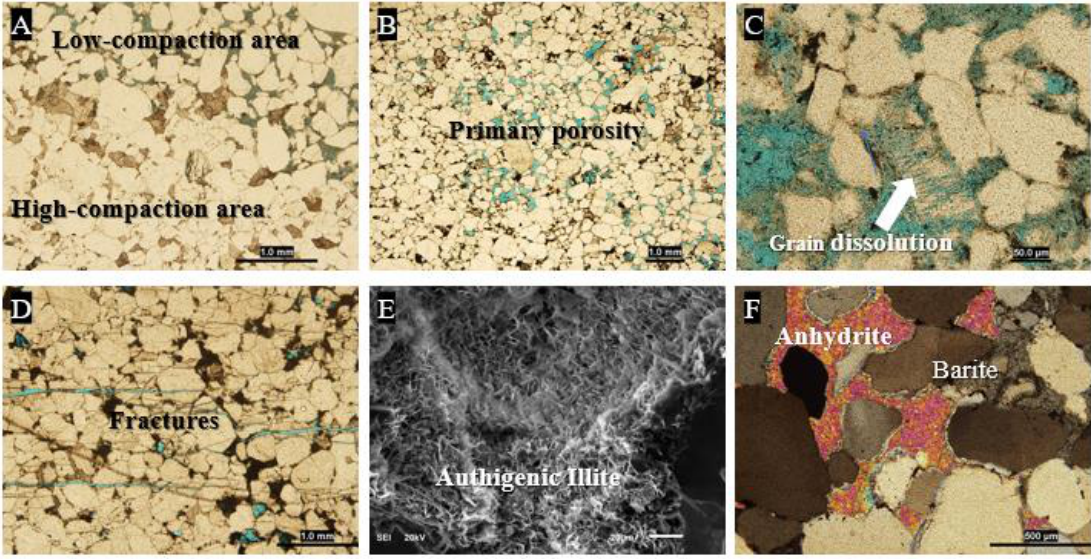
Figure 6. Photomicrographs for microfacies observed in the analyzed samples. ( A ) Heterogenous patterns of grain compactions, ( B ) interparticle porosity associated with grain compaction, ( C ) intraparticle porosity due grains dissolution, ( D ) fractures associated with grain compactions, ( E ) authigenic pore-filling illite, ( F ) pore-filling anhydrite and barite cement.